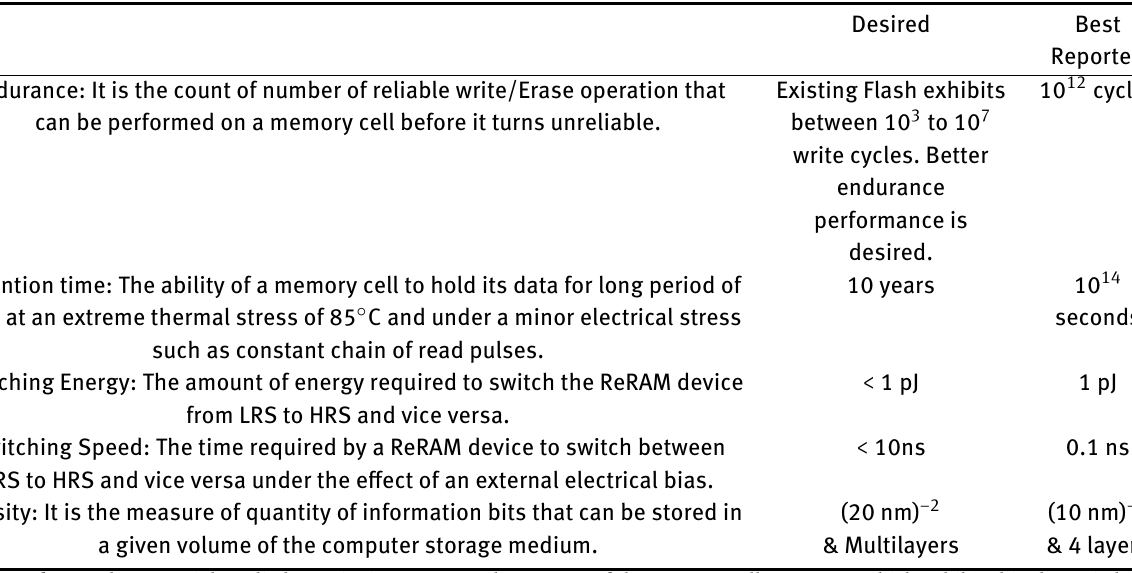
Table 1: Definitions and Quantitative estimates for required performance metrics of ReRAM